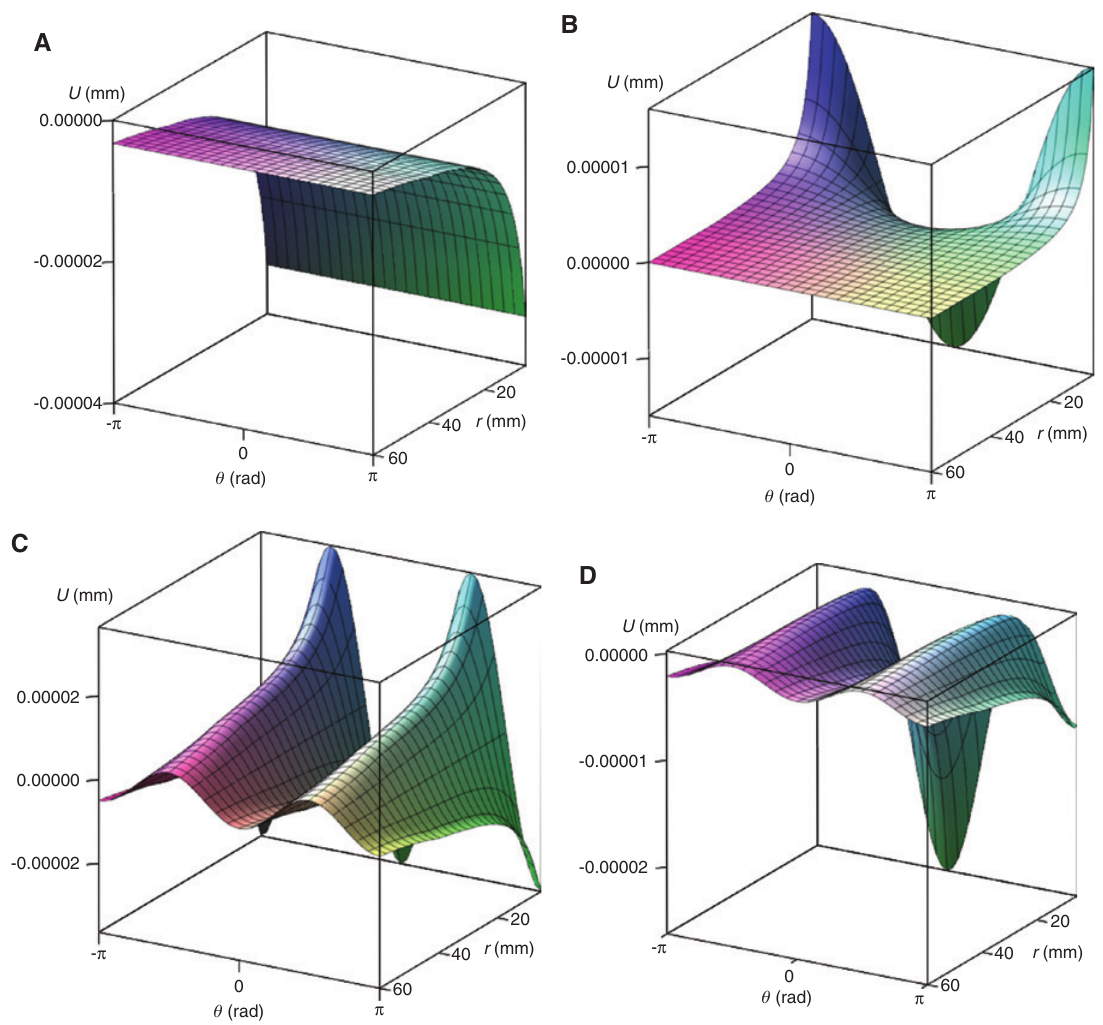
Figure 10: The near-field radial displacements of the joint with FGM inter-layer ( n = -1): (A) λ = 0, (B) λ = 1, (C) λ = 2, and (D) weighted superposi- tion of A, B, and